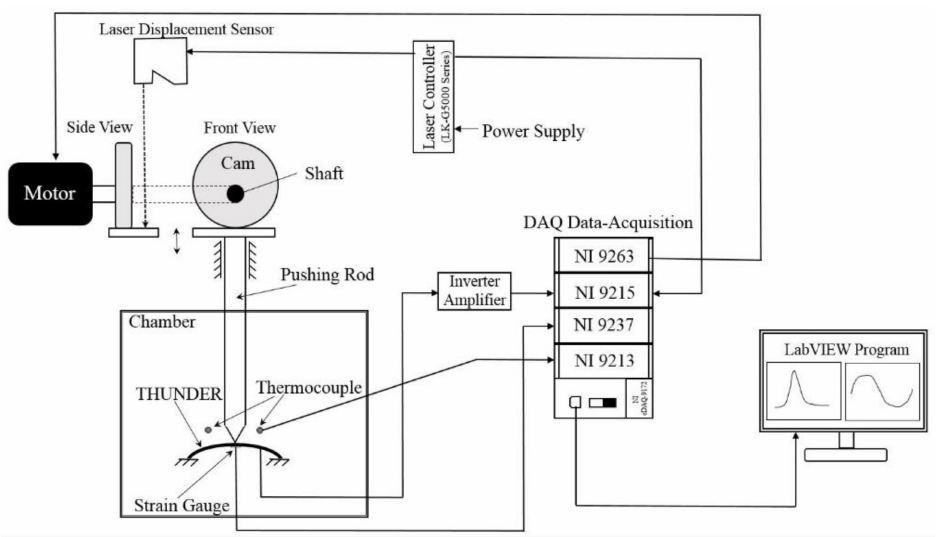
Figure 5. Schematic diagram of the experimental